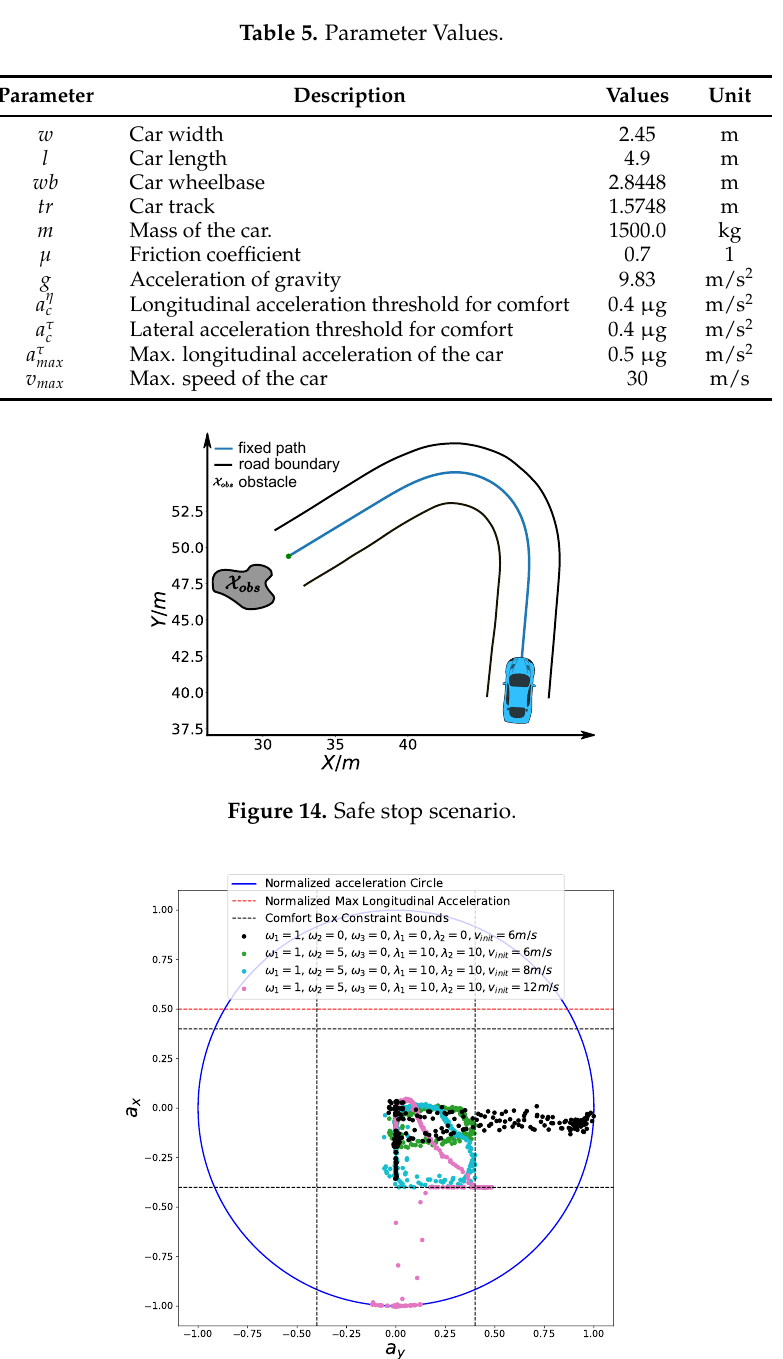
Figure 15. Friction circle for the safe stop